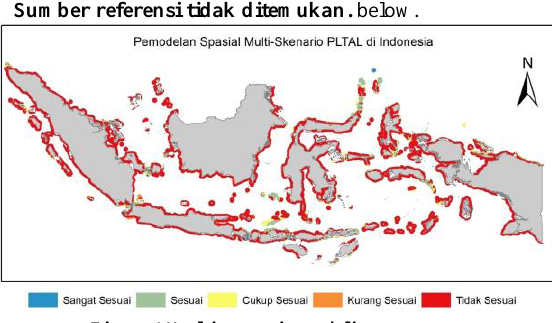
Figure 4 Multi-scenario modeling Based on the results of multiskenario modeling, it was obtained that as a large coastal area in Indonesia has a class of conformity is not appropriate to be built